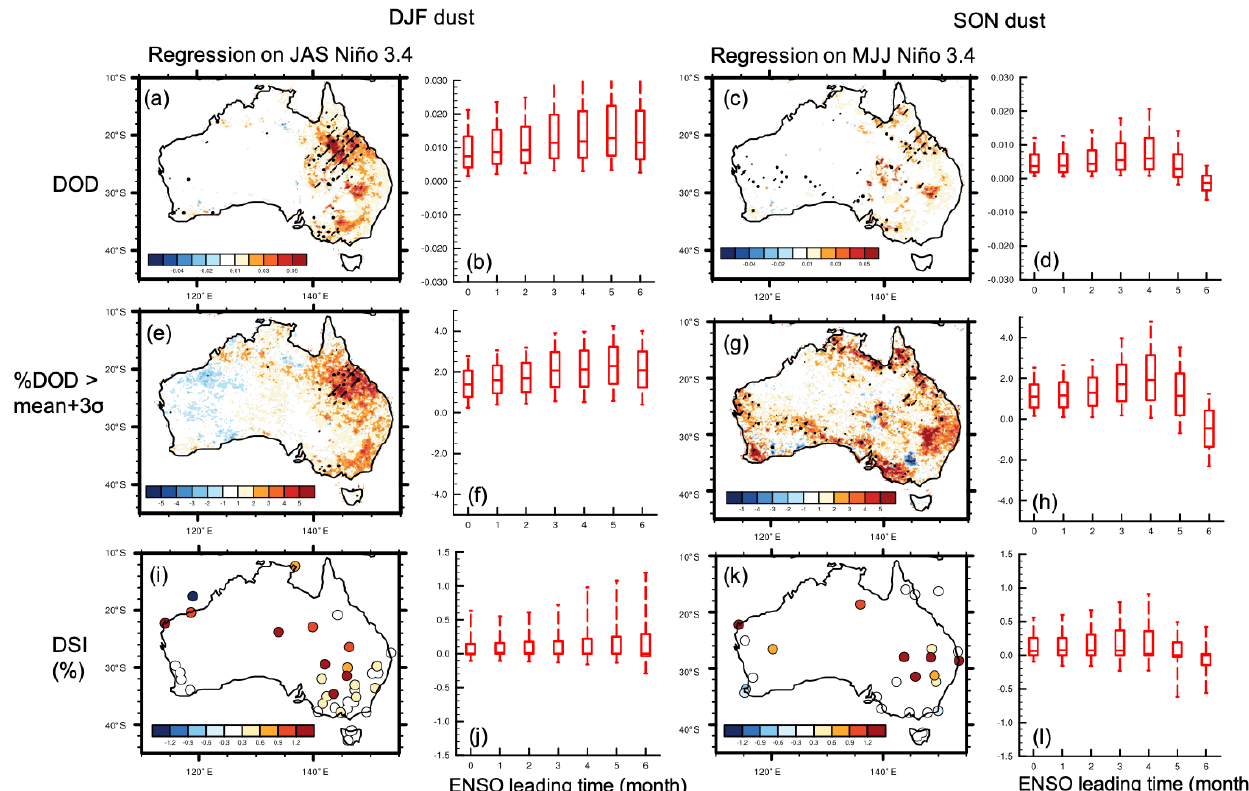
Figure 9. Regression of anomalies in seasonal dust activity in (a, b, e, f, i, j) December–February (DJF) and (c, d, g, h, k, l) September– November (SON) upon antecedent Niño 3.4. Analyzed dust variables include seasonal (a–d) DOD averaged from MODIS-Terra and MODIS- Aqua, (e–h) frequency of daily DOD anomaly exceeding 3 times the interannual standard deviation, and (i–l) DSI. (a, c, e, g, i, k) Regression coefficient between (a, e, i) DJF dust and antecedent July–September (JAS) Niño 3.4 (ENSO leading dust for 5 months), and (c, g, k) SON dust and antecedent May–July (MJJ) Niño 3.4 (ENSO leading dust for 4 months). In (a, c, e, g) , the stitches indicate regions with significant regression coefficient ( p < 0 . 05), based on Monte Carlo bootstrap test; and the slashes further denotes regions with significant positive correlation between MODIS DOD and MISR nsAOD. In (i, k) , only statistically significant regression coefficients ( p < 0 . 05) are shown. (b, d, f, h, j, l) Boxplot of the regression coefficient of seasonal dustiness on Niño 3.4 at different antecedent times as a function of the leading time of Niño 3.4, showing the 5th, 25th, 50th, 75th, and 95th percentiles of regression coefficient at all pixels within the dust source region (25–35 ◦ S, 135–155 ◦